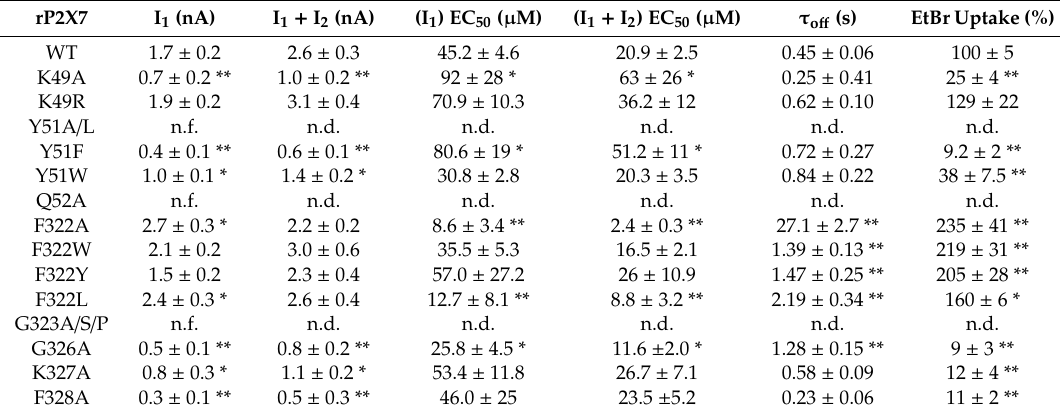
Table 1. Characterization of single-point vestibule mutants of rat P2X7